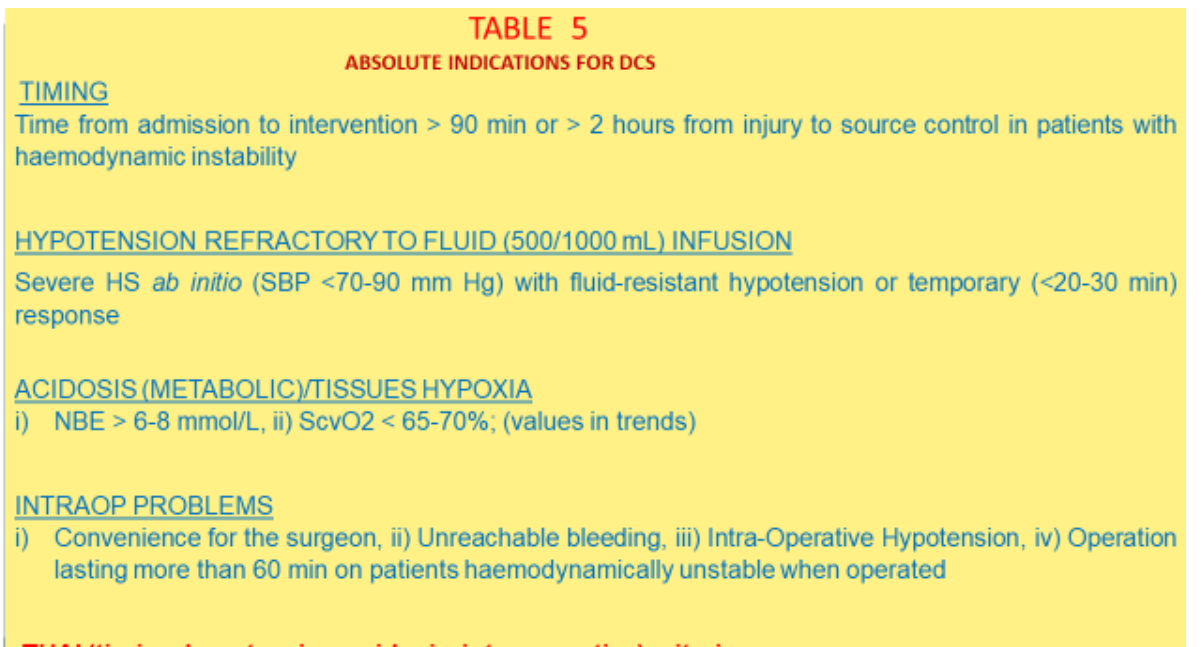
Figure 5. Criteria for damage control surgery. DCS = damage control surgery; SBP= systolic blood pressure; NBE = negative base excess; ScvO2 =central venous oxygen saturation.